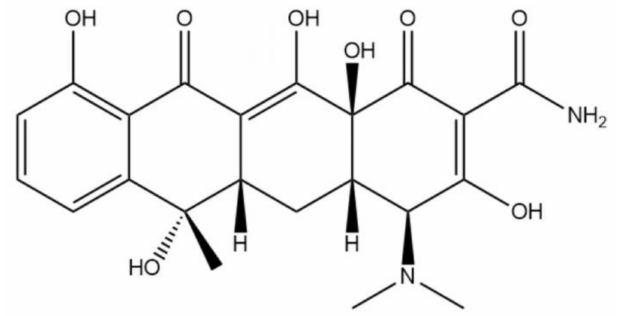
Figure 1. The molecule structure of